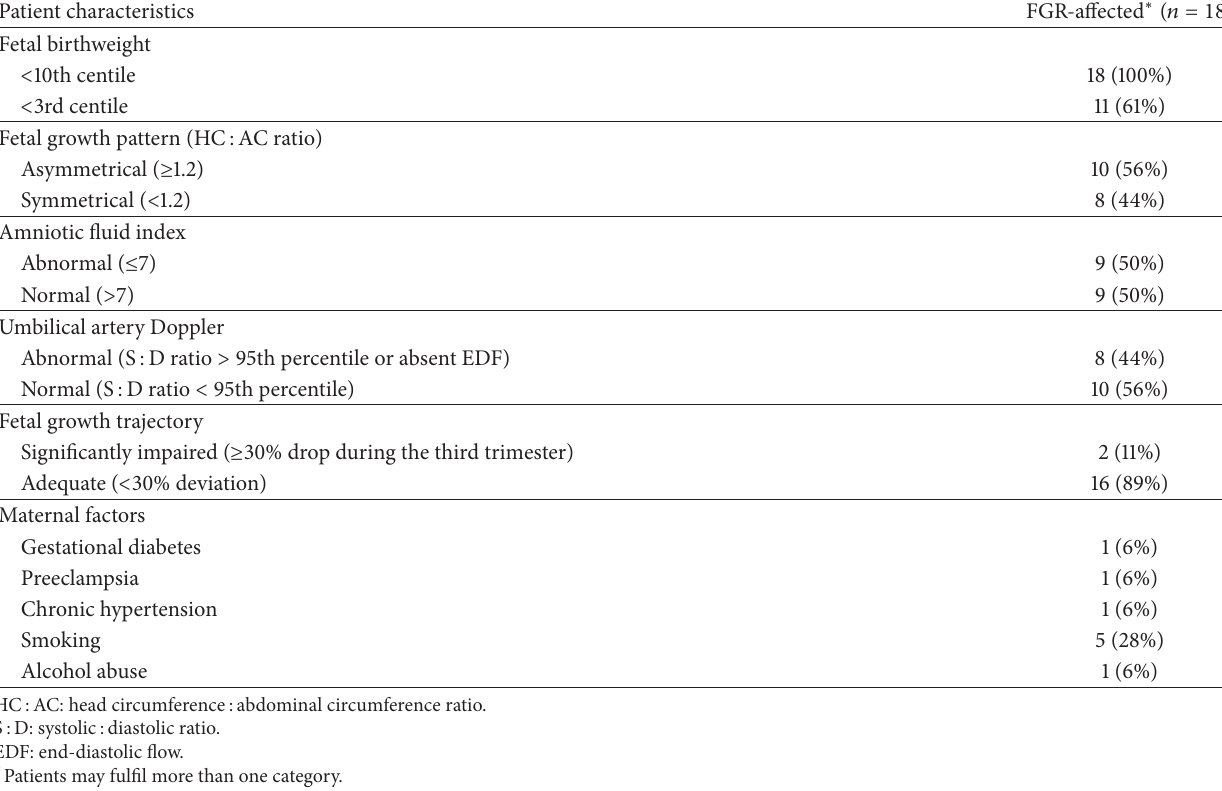
Table 1: Clinical inclusion criteria for FGR.